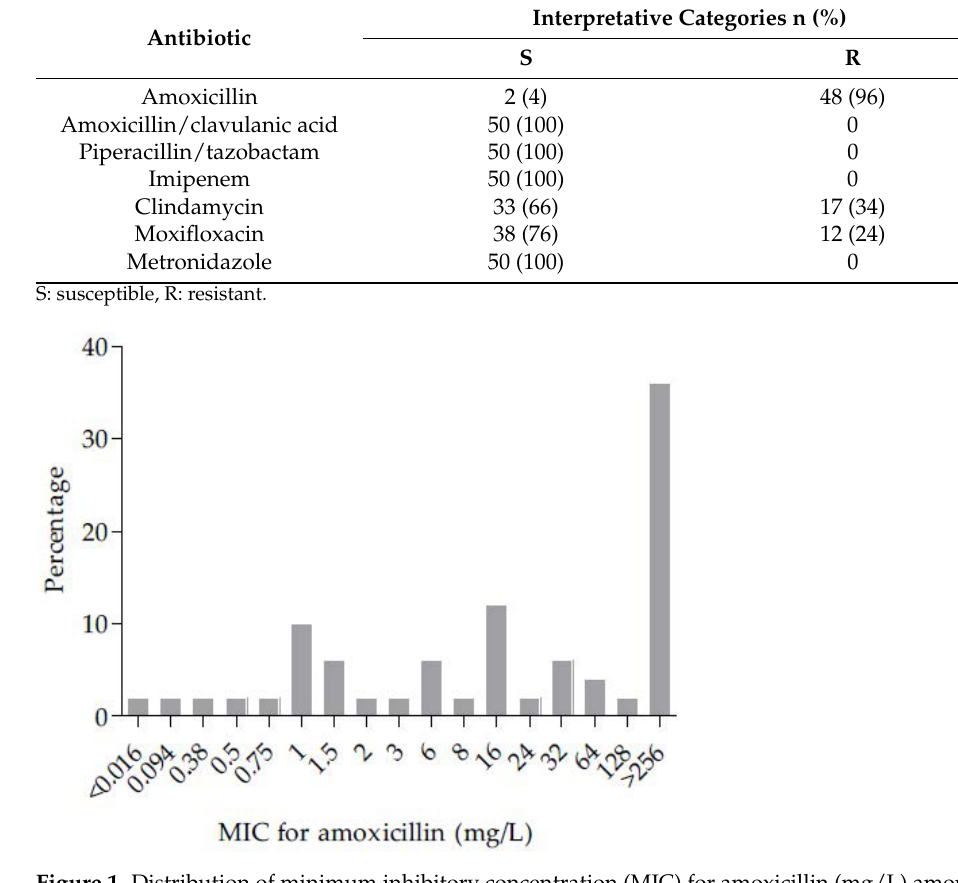
Figure 1. Distribution of minimum inhibitory concentration (MIC) for amoxicillin (mg/L) among the 50 isolates of Prevotella melaninogenica